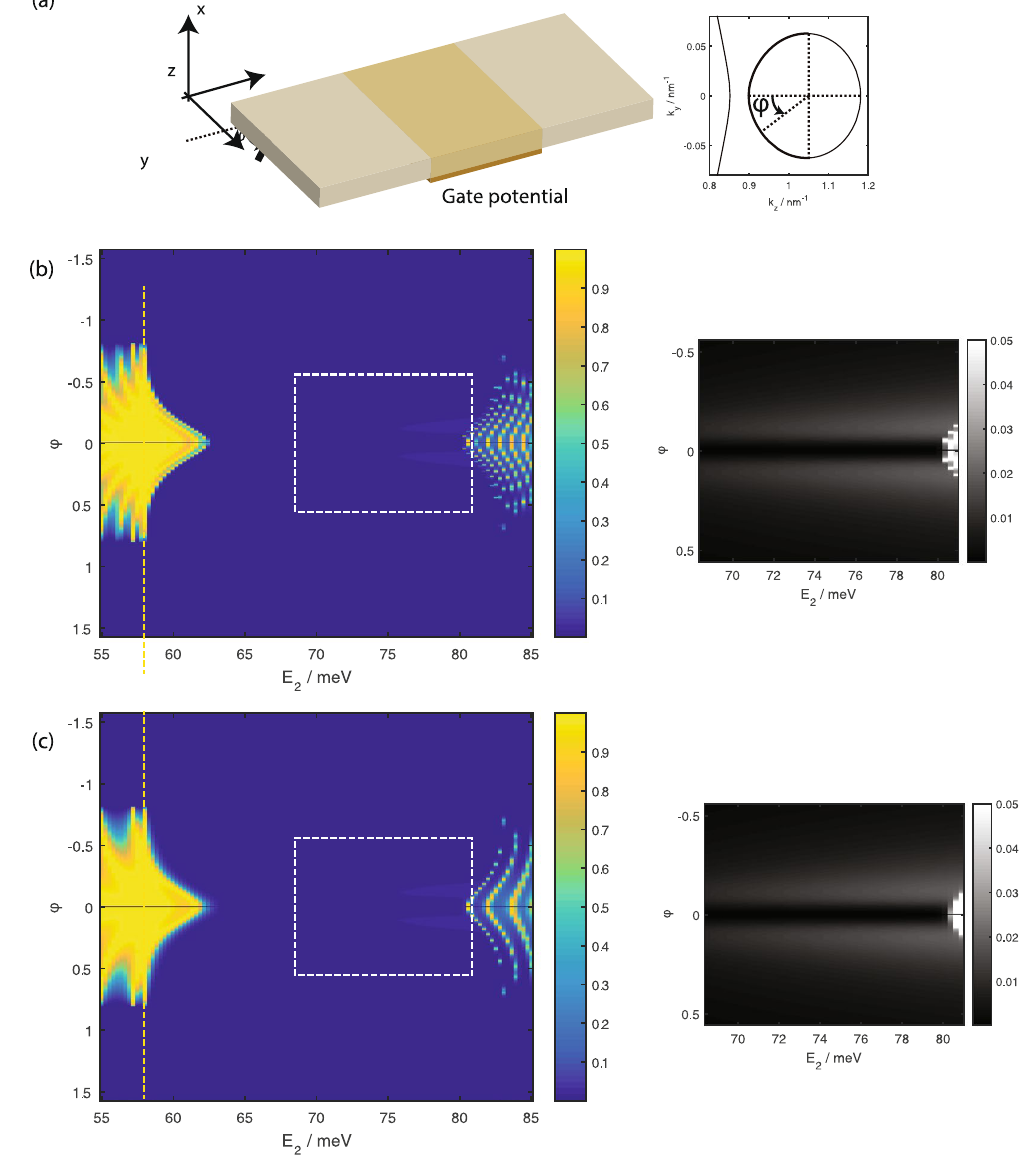
Figure 2. ( a ) A schematic of the tunneling setup consisting of a central segment subjected to a gate potential sandwiched between semi-infinite long source and drain leads. ( b ) and ( c ) show the transmission as a function of the angular coordinate ϕ along the positive k z Dirac ‘cone’ (see inset of panel (a) for definition of ϕ ), and E 2 in the central segment for a central segment of length ( b ) 100 nm and ( c ) 50 nm. ϕ is roughly equal to the incident angle of the source current incident on the source-central segment interface as indicated in the main diagram of panel (a). The vertical yellow dotted line in panel (b) indicates the energy of the source and drain segments. The insets on the right of the main figures in panels (b) and (c) show the transmission within the E 2 − ϕ range inside the dotted box of the main figures with the maximum transmission shown capped at 0.05 to emphasise the small but finite transmission due to tunneling to the Fermi arc